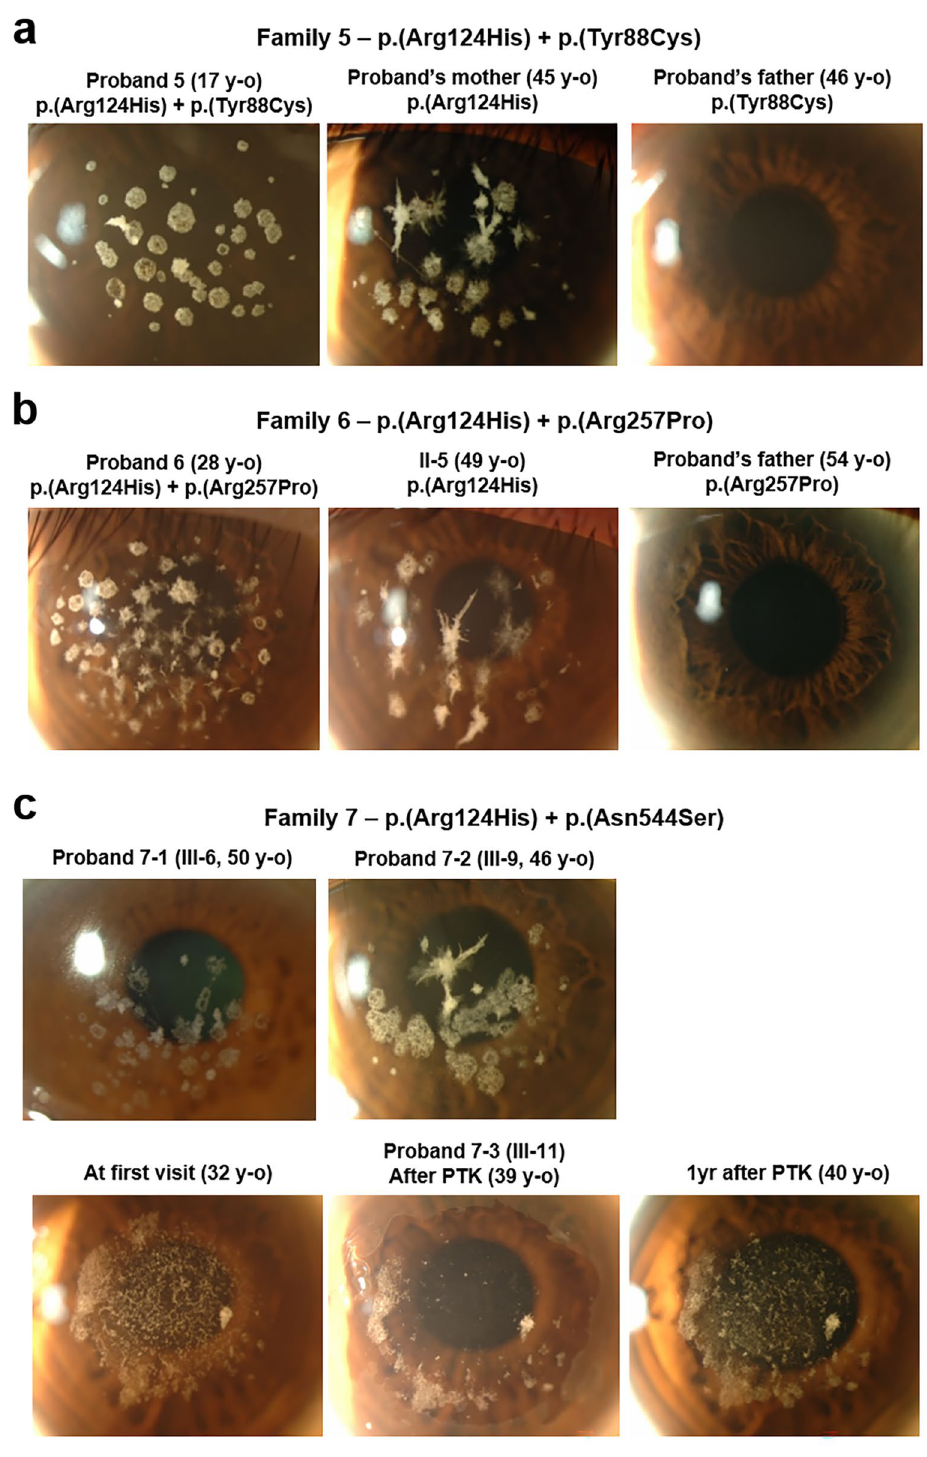
Figure 3. TGFBI p.(Tyr88Cys), p.(Arg257Pro), and p.(Asn544Ser) mutations were accompanied by p.(Arg124His) mutation in patients with severe phenotypes. ( a ) Slit-lamp photographs of Proband 5 and her parents (Family 5). The proband showed numerous large discoid granular deposits. However, her mother carrying heterozygous p.(Arg124His) variant showed age-appropriate disease pattern, while the father carrying heterozygous p.(Tyr88Cys) variant showed no disease phenotype. ( b ) Slit-lamp photographs of the members of Family 6. Compound heterozygosity of TGFBI p.(Arg124His) and p.(Arg257Pro) mutations caused severe GCD2 phenotypes compared to the heterozygosity of TGFBI p.(Arg124His) mutation alone, although heterozygosity of TGFBI p.(Arg257Pro) mutation did not cause disease. ( c ) Slit-lamp photographs of Proband 7 carrying compound heterozygous mutations of TGFBI (p.(Arg124His) and p.(Asn544Ser)). The recurrence was very rapid after phototherapeutic keratectomy